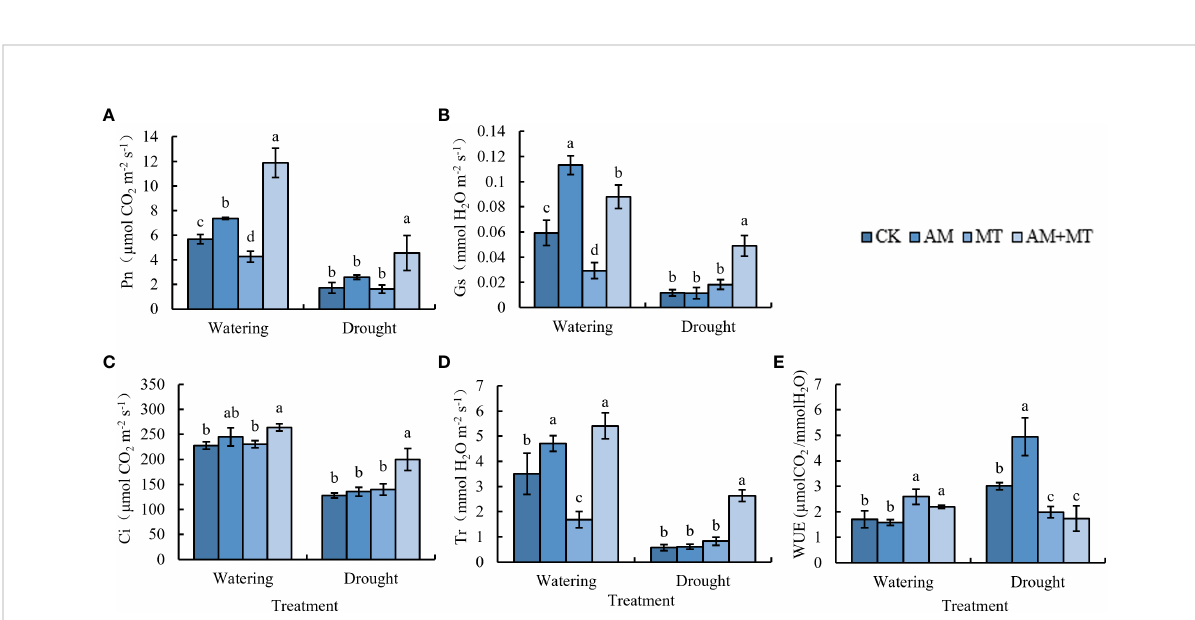
FIGURE 5 Effect of treatments on gas exchange parameters in kiwifruit seedlings under well-watering or drought stress, including net photosynthetic rate (A) , stomatal conductance (B) , intercellular CO 2 concentration (C) , transpiration rate (D) and water use ef fi ciency (E) . Data are presented as meant ± SD ( n = 6), different letters indicate signi fi cant differences between treatments at p < 0.05 (Tukey ’ s Post Hoc test). Treatments included CK (the control), AM (inoculated with arbuscular mycorrhiza), MT (irrigated with 100 m M melatonin), and AM+MT (treated with melatonin and arbuscular mycorrhiza).